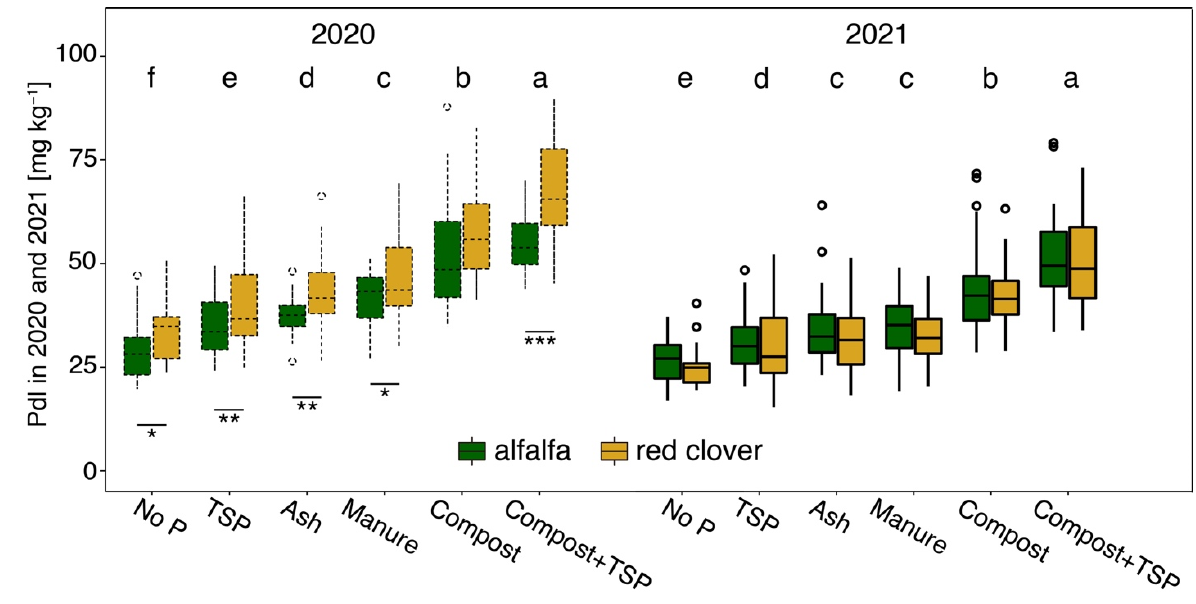
Figure 5. Double lactate extractable phosphorus (Pdl) in the topsoil (0 to 30 cm) of the six studied treatments (no P, TSP, ash, manure, compost, and compost + TSP) with cultivation of alfalfa (green) and red clover (brown) in 2020 (framed with dotted lines) and 2021 (framed with solid lines). Letters indicate a significant difference between treatments (based on average of plant species) within the same year (Duncan’s new multiple range test with p < 0.05). Whiskers and asterisks indicate a significant interspecific difference between the respective treatments. Mean ± standard deviation (n = 32).